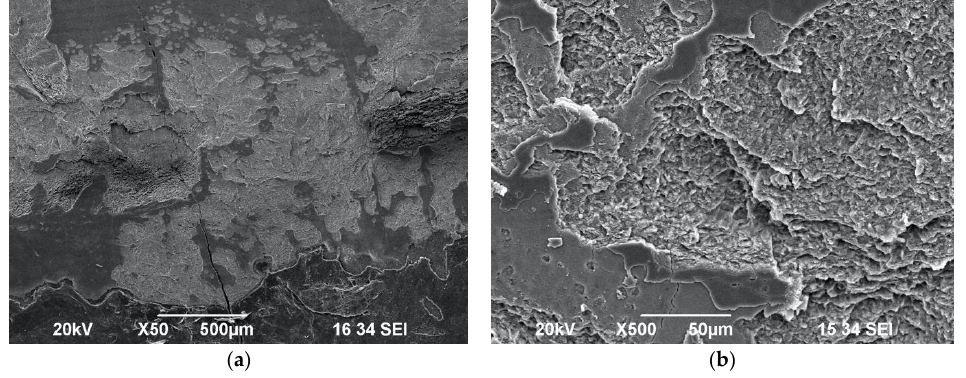
Figure 8. SEM images of enamel surface morphology following irradiation with 1 W/20 Hz/50 mJ/17 J/cm 2 with no water spray cooling—Group H—under ×100 magnification ( a ) and under ×500 magnification ( b ), showing scaly surface and wide-diameter impact craters with exposed prisms.